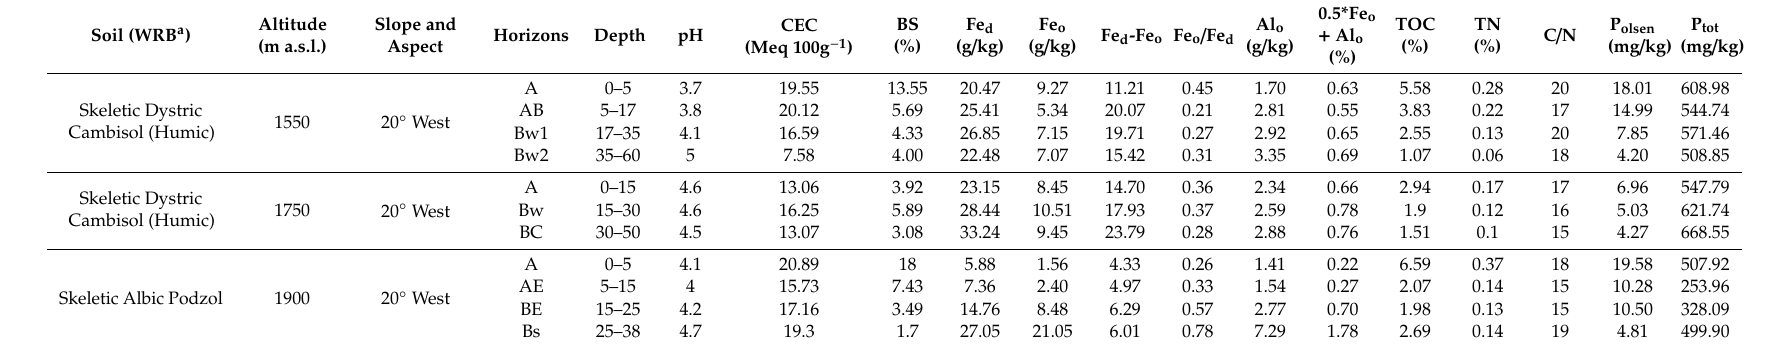
Table 4. Main characteristics of the study sites and soils along the elevational